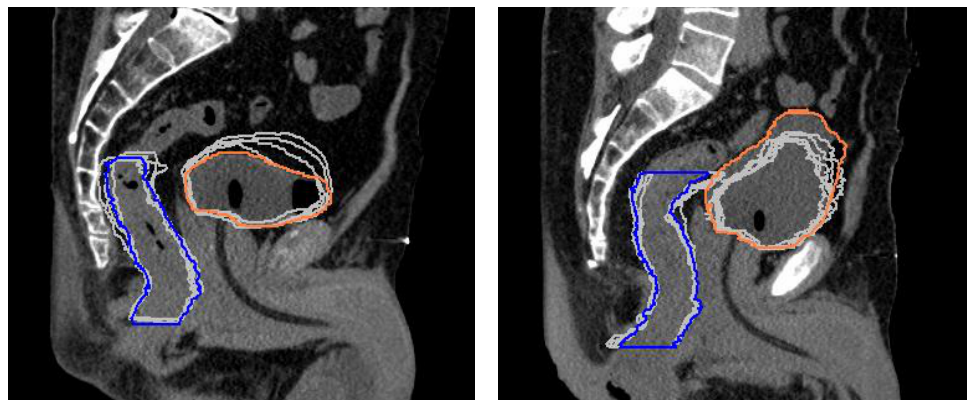
Figure 3. Superposition of rectum and bladder contours from the planning CT (colored lines) and each treatment fraction (gray lines) for the two patients who had the minimum ( left ) and maximum ( right ) bladder volume in the simulation.